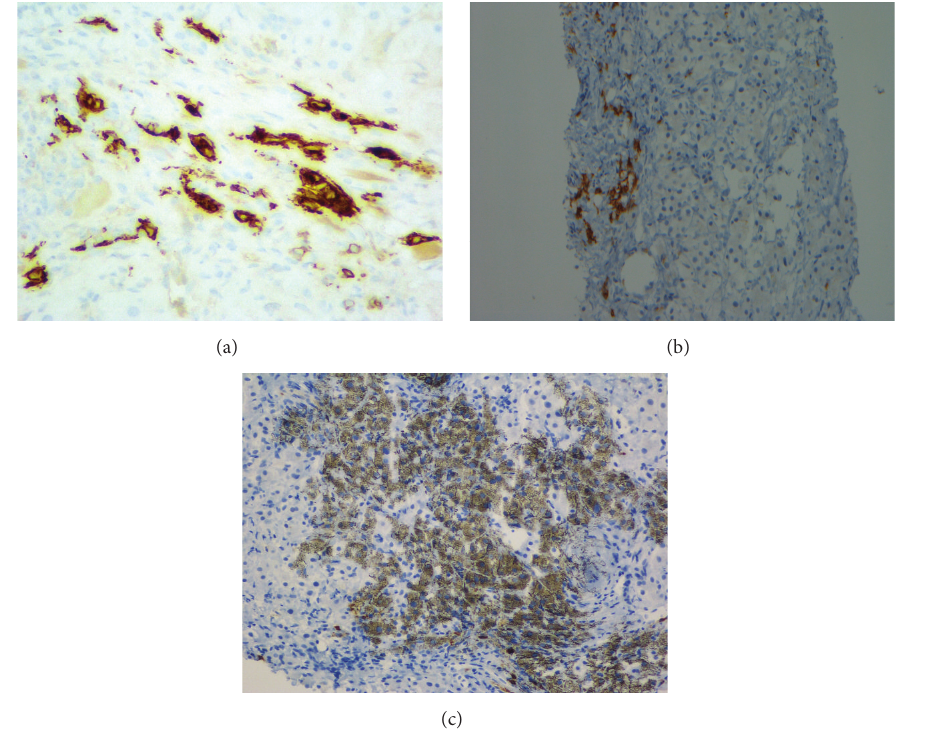
Figure 2: Liver biopsy immunohistochemical staining showing mast cells positive for CD117 (a), CD25 (b), and mast cell tryptase (c). Of note, (c) is zoomed in on the portion of the liver that is positive for mast